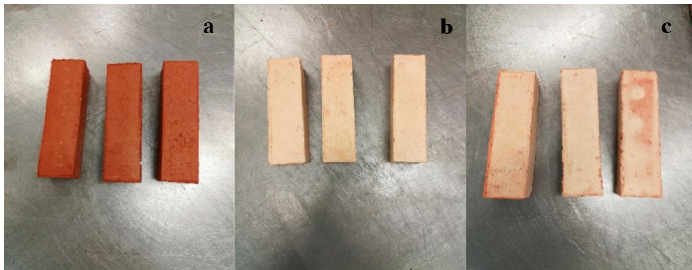
Figure 8. ( a ) Reference 4:1 clay:sand, ( b ) 8:1:1 clay:sand:EPP-EPA coarse and ( c ) 8:1:1 clay:sand:EPP-EPA. Table 6. Physical properties of sintered bricks.